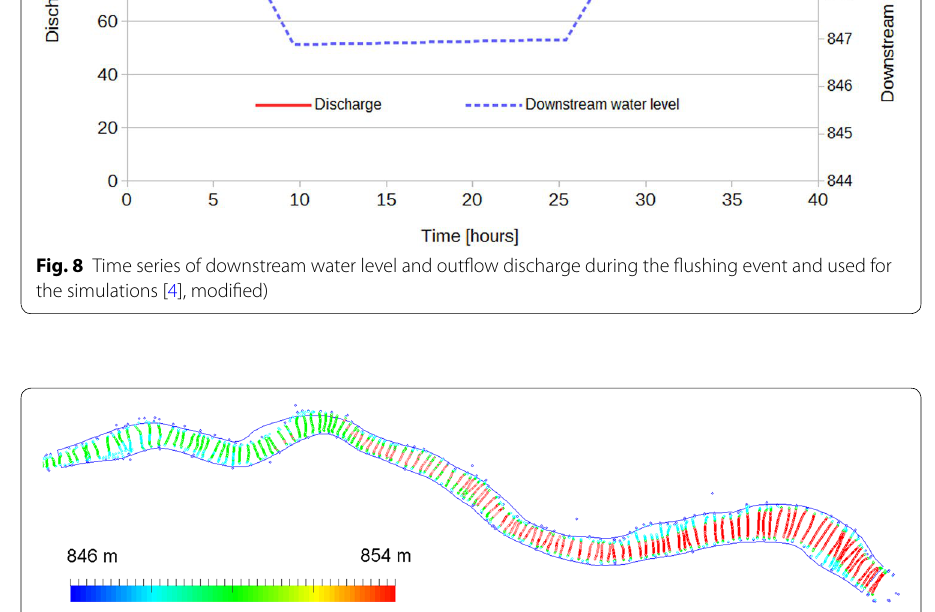
Fig. 9 Plan view of the Bodendorf reservoir, showing the bathymetric survey before the flushing in 2004. Different colours represent bed